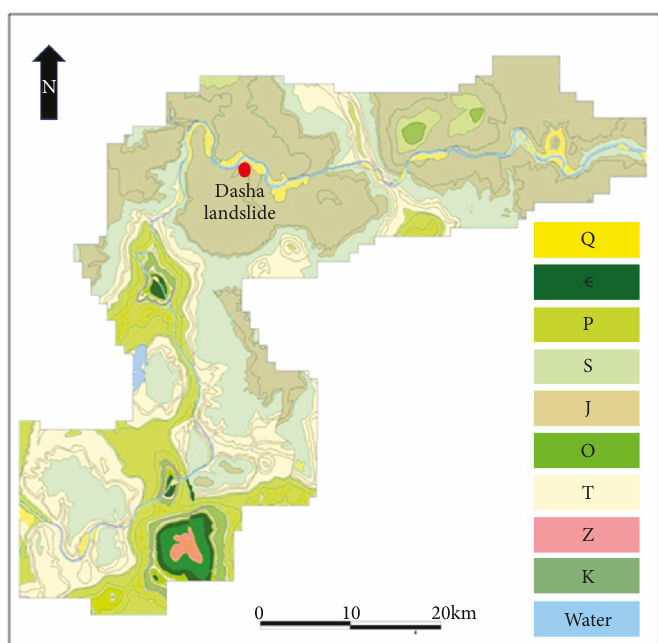
Figure 2: Generalized geological map of the Xiangjiaba reservoir area. Where Sinian system =Z; Cambrian system = Є ; Ordovician system =O; Silurian system =S; Permian system =P; Triassic system =T; Jurassic system =J; Cretaceous system =K; Quaternary system=Q.